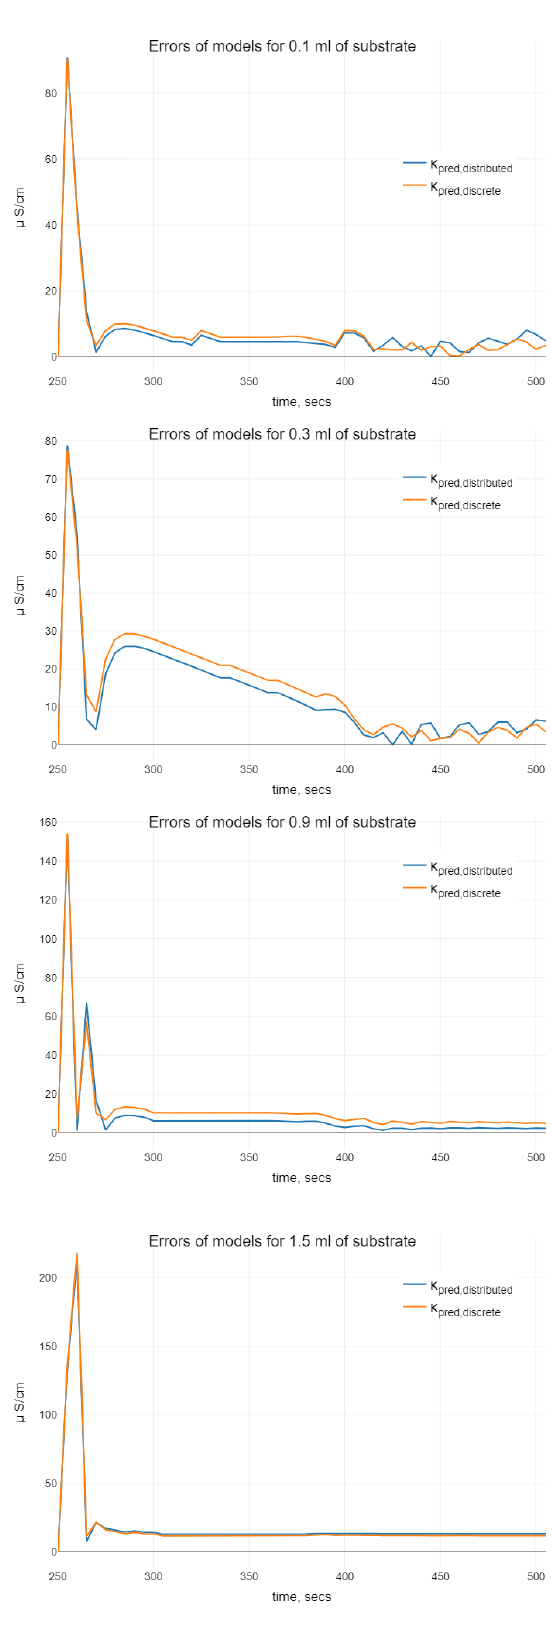
Figure 5. Error analysis of predicted trajectories with the help of (11) and (4): denotes the errors of κ pred , distributed , denotes the errors of κ pred , discrete